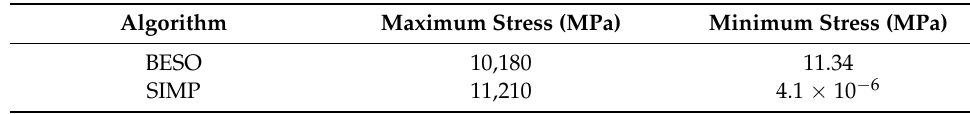
Figure 14. The stress nephograms of the design domain of the optimized joint under the shear con- dition: ( a ) BESO; ( b ) SIMP.